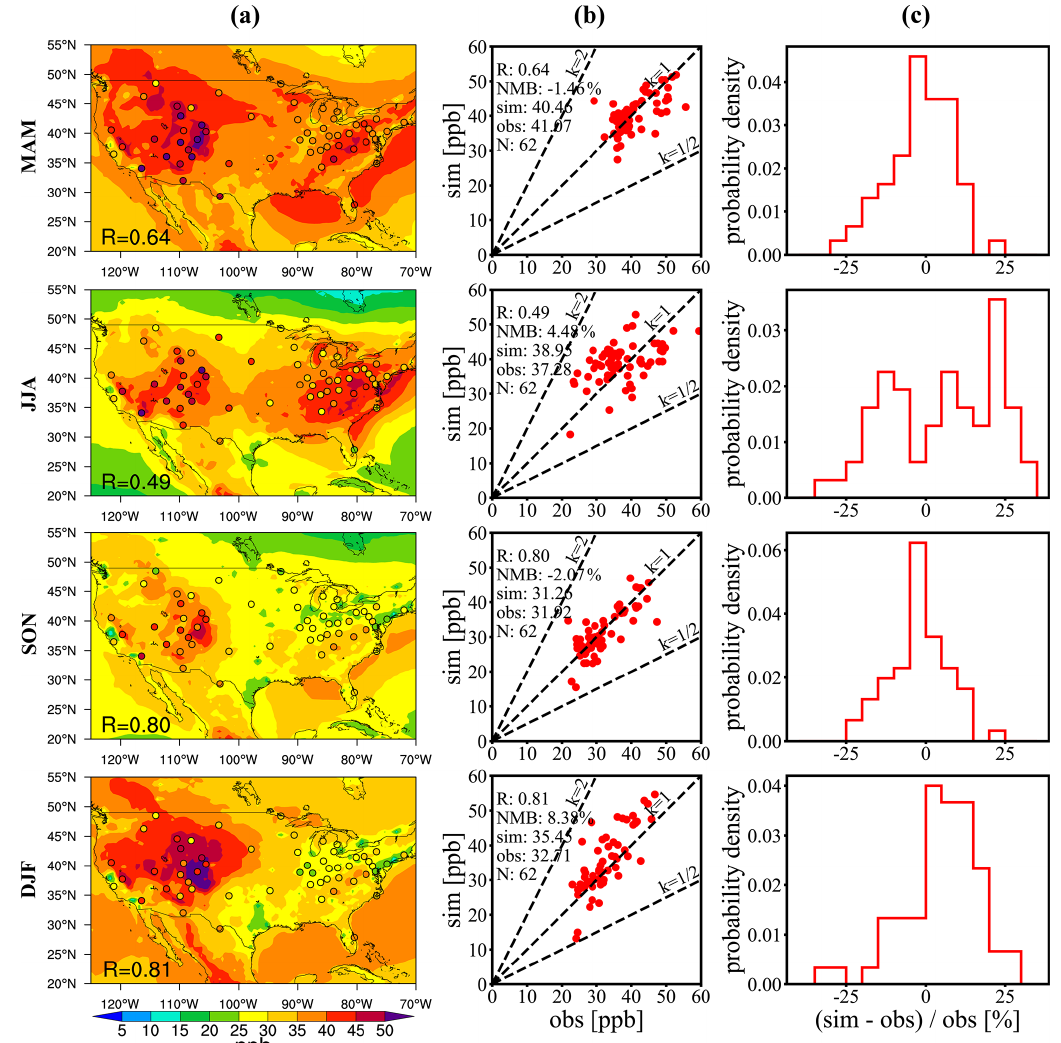
Figure 11. Same as Fig. 7 but in the United